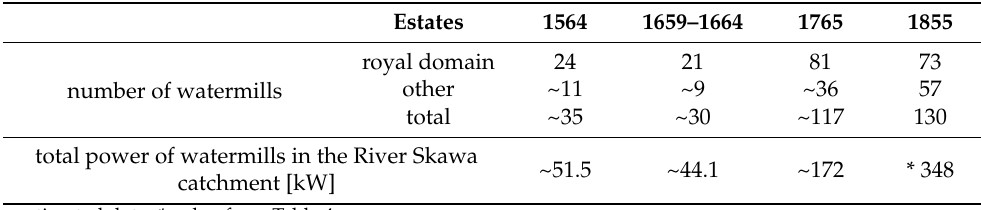
Table 2. The number of watermills in the 16th–18th centuries in the River Skawa catchment area